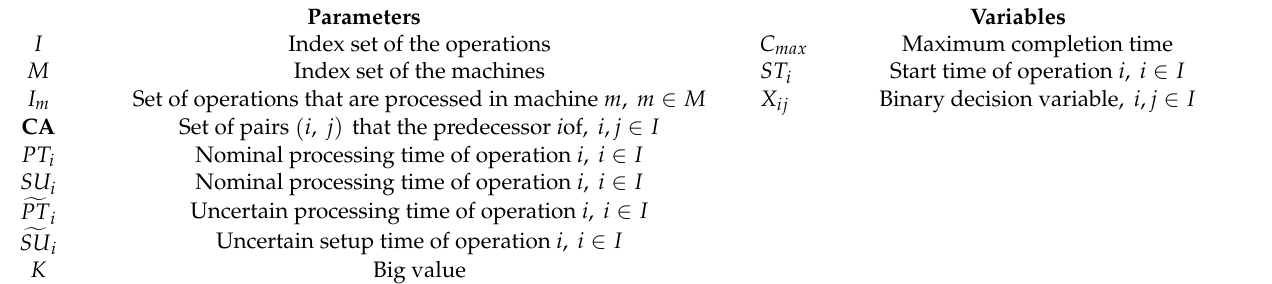
Table 1. Parameters and variables for